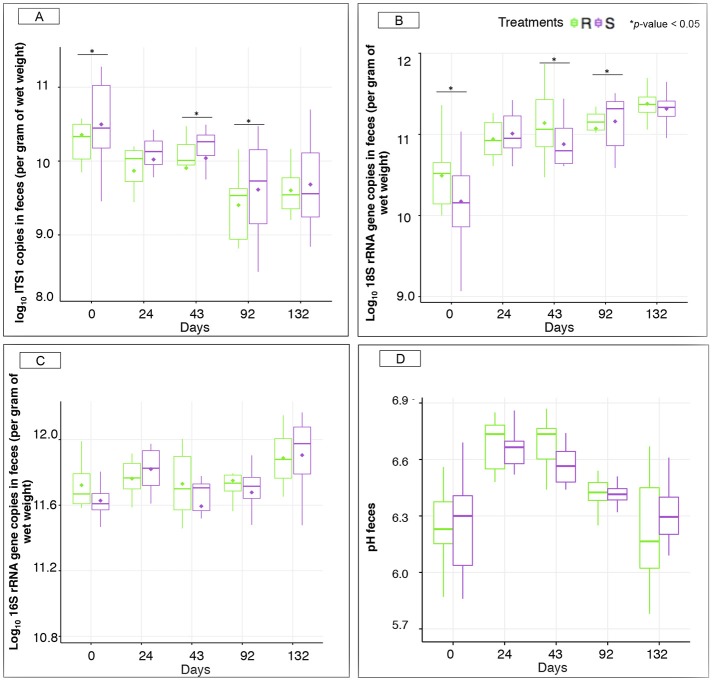
Microbiological concentrations and pH between susceptible and resistant ponies across time. (A) Boxplot graph representation of concentrations of anaerobic fungi in feces between S and R animals at different time points; (B) Boxplot graph representation of concentrations of protozoa in feces between S and R animals at different time points; (C) Boxplot graph representation of concentrations of bacteria in feces between S and R animals at different time points; (D) Boxplot graph representation of pH in feces between susceptible (S) and resistant (R) animals at different time points. In all cases, S animals are colored in purple and R animals in green. *p < 0.05 for comparison between S and R ponies in each time point.